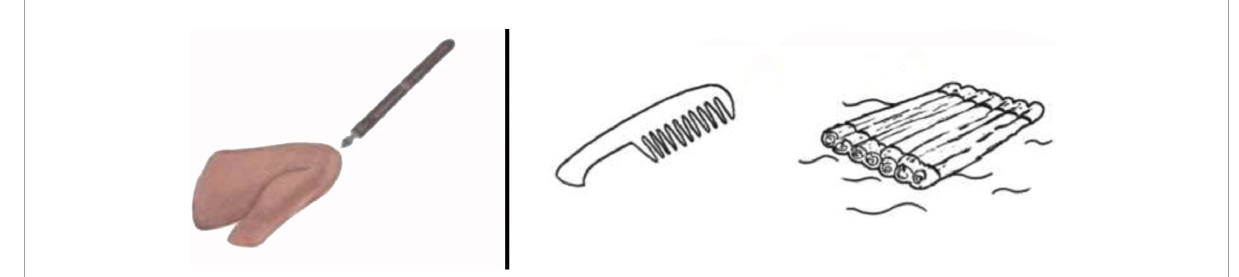
FIGURE1 Rebuses from Shevrin and Luborsky (1961) and from Steinig et al. (2017). (Left) The penny rebus composed of the image of a pen and of a knee from the Shevrin and Luborsky (1961) experiment; (right) the rebus kampflos (without a fight) composed of the image a comb ( Kamm ) and of a raft ( Floß ) from the Steinig et al. (2017)